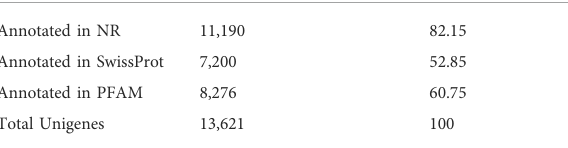
TABLE 5 Summary statistic of F. solani species complex bio fi lm transcriptome